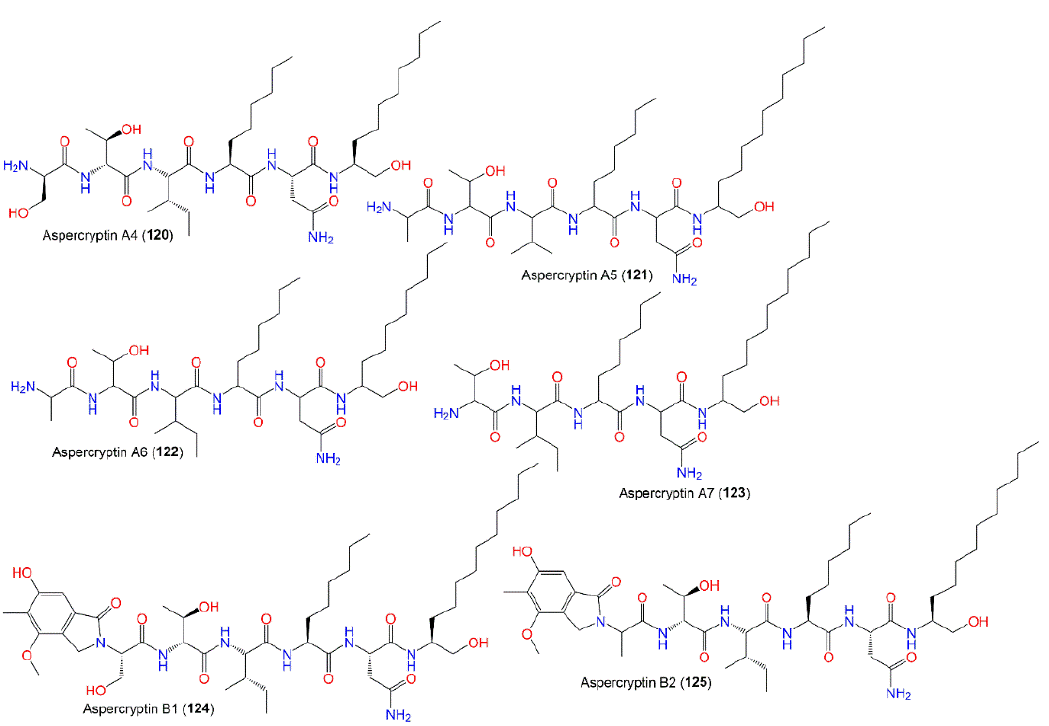
Figure 12. Structures of peptides ( 120 – 125 ).